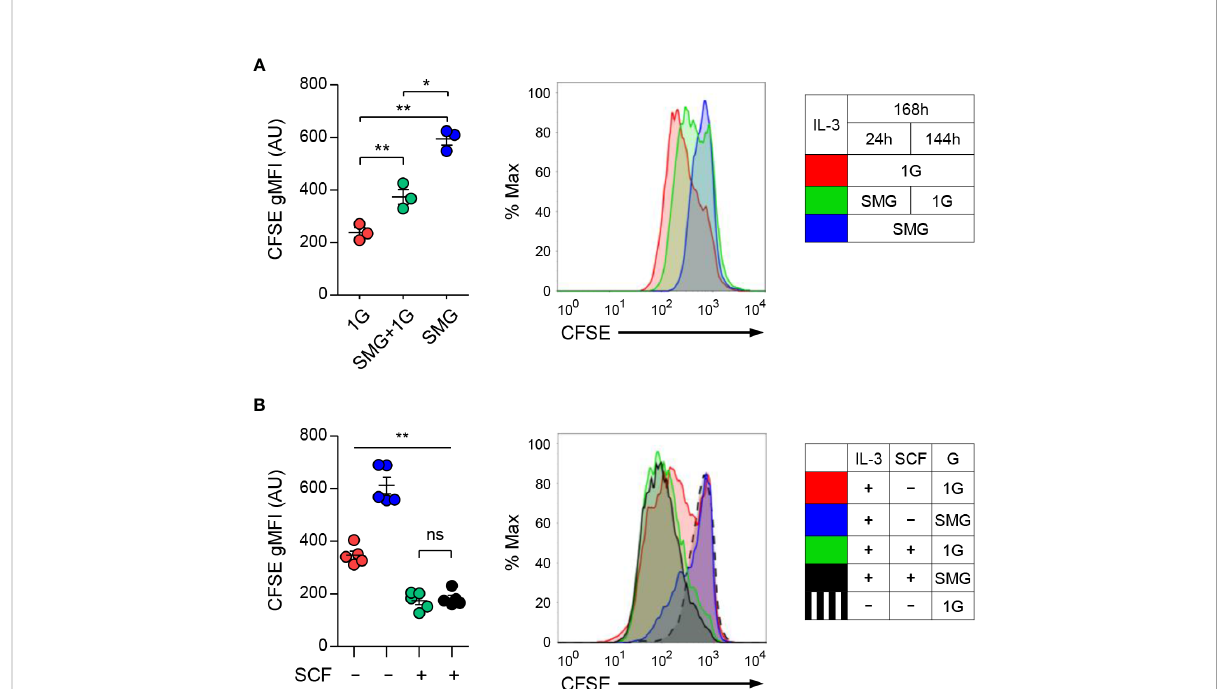
FIGURE 3 Effects of SMG on the proliferation of mast cells. (A) Carboxy fl uorescein succinimidyl ester (CFSE)-labeled BMMCs were cultured with IL-3 under 1G, SMG+1G, and SMG conditions for 168 h. CFSE is a cell-permeable dye diluted during cell division. After the exclusion of A5-stained cells, CFSE dilutions were monitored using fl ow cytometry. Data are shown as the mean ± SEM (n = 3). (B) CFSE-labeled cells were cultured with IL-3 ± SCF under SMG or 1G for 168 h and cell proliferation was analyzed using fl ow cytometry. Data are shown as the mean ± SEM of 5 experiments. The gMFI of each graph represents the cell proliferation activity. CFSE-labeled cells cultured without IL-3 and SCF were used as a negative control for cell proliferation (black dashed line). The P-value comparisons between all groups in (B) were determined as **p < 0.01 except ns, not signi fi cant. *p <